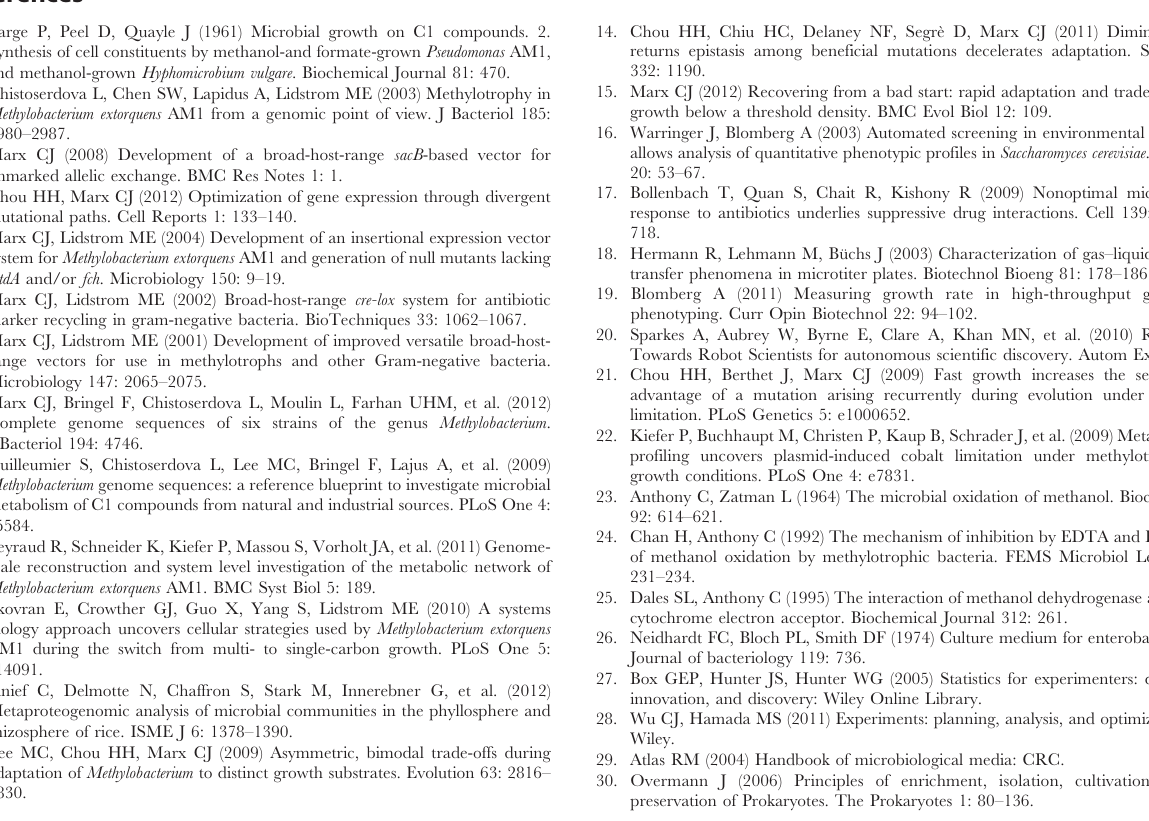
Table S1 The recipe for the new MP medium and C7 trace metal